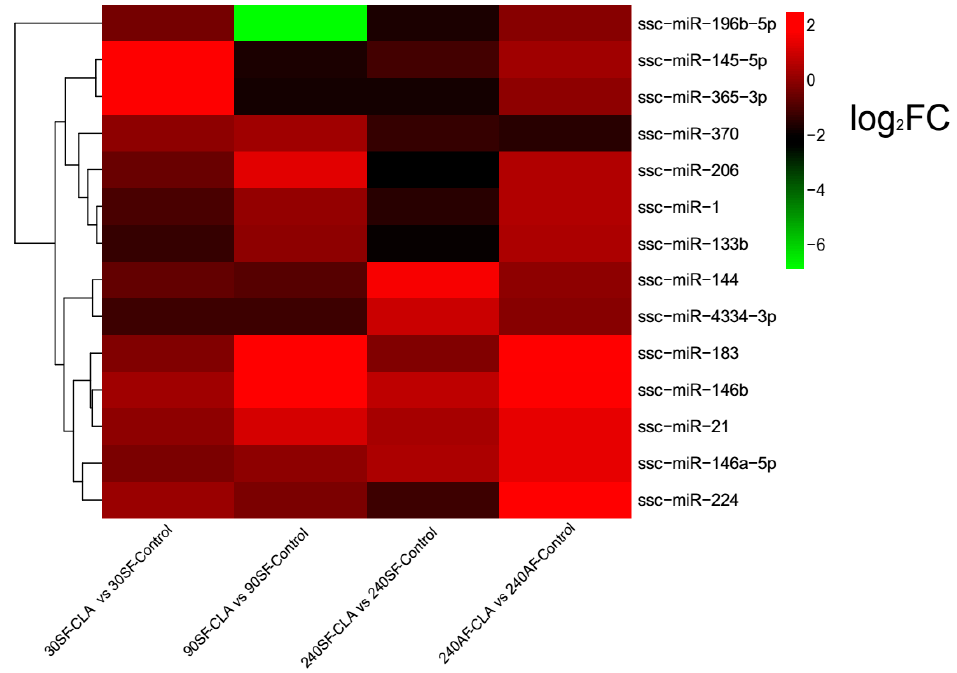
Figure 2. Hierarchical clustering analysis for 14 differentially expressed miRNAs for CLA group versus control group from sequencing. Abbreviations: 30SF, 90SF, and 240SF: dorsal subcutaneous adipose tissue at 30, 90, and 240 days old, respectively; 240AF: abdominal adipose tissues at 240 days old. Log 2 FC: log2 fold change. Table 2. Differentially expressed miRNAs in response to 1.5% CLA treatment from deep